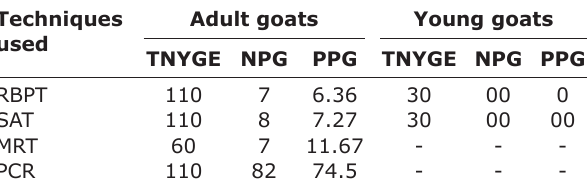
Table-2: Age-wise diagnosis of brucellosis in goats determined by various tests used during the current investigation.